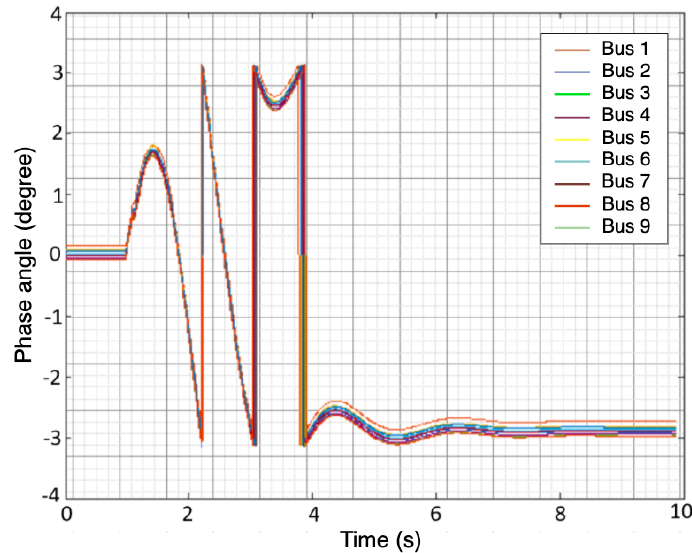
Figure 1. Phase angle of the 9 buses after injecting three—phase